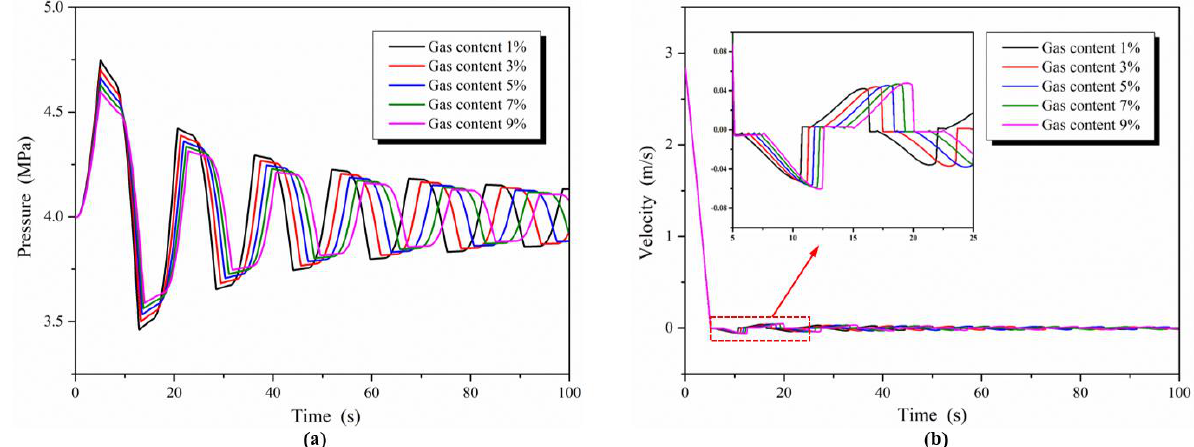
Figure 12. Influence of gas content on pressure and velocity fluctuation at the end of a pipeline: ( a ) represents pressure response; ( b ) represents velocity response.